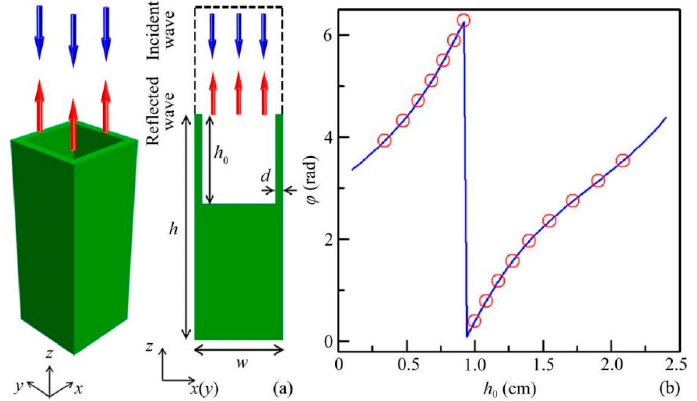
Figure 1. Design of a quasi-3D reflected unit. ( a ) Schematic of a quasi-3D reflected unit and its x ( y )- z cross section. ( b ) Reflected phase delays created by the quasi-3D reflected unit as a function of tunable depth h 0